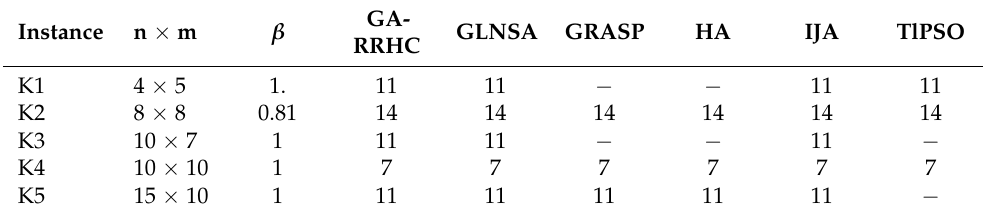
Table 4. Kacem dataset